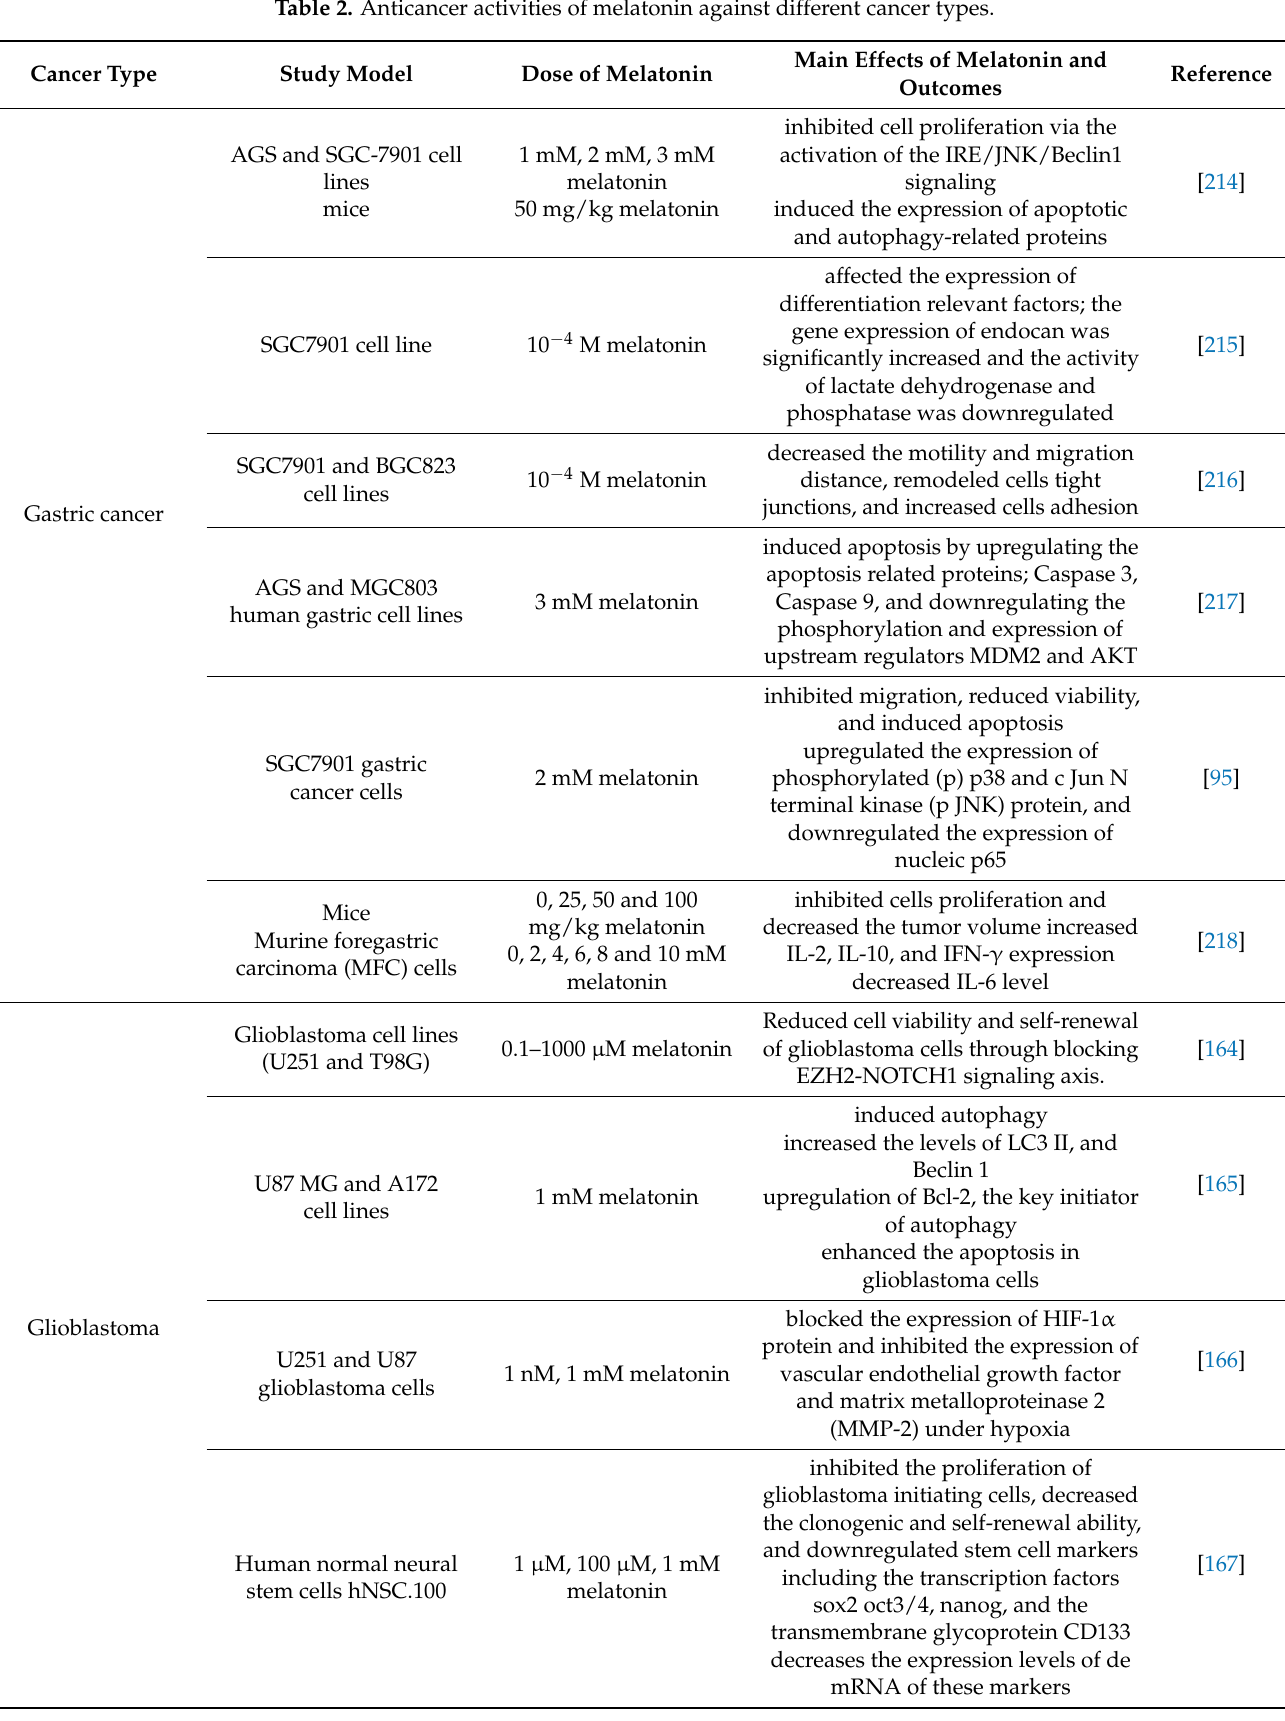
Table 2. Anticancer activities of melatonin against different cancer